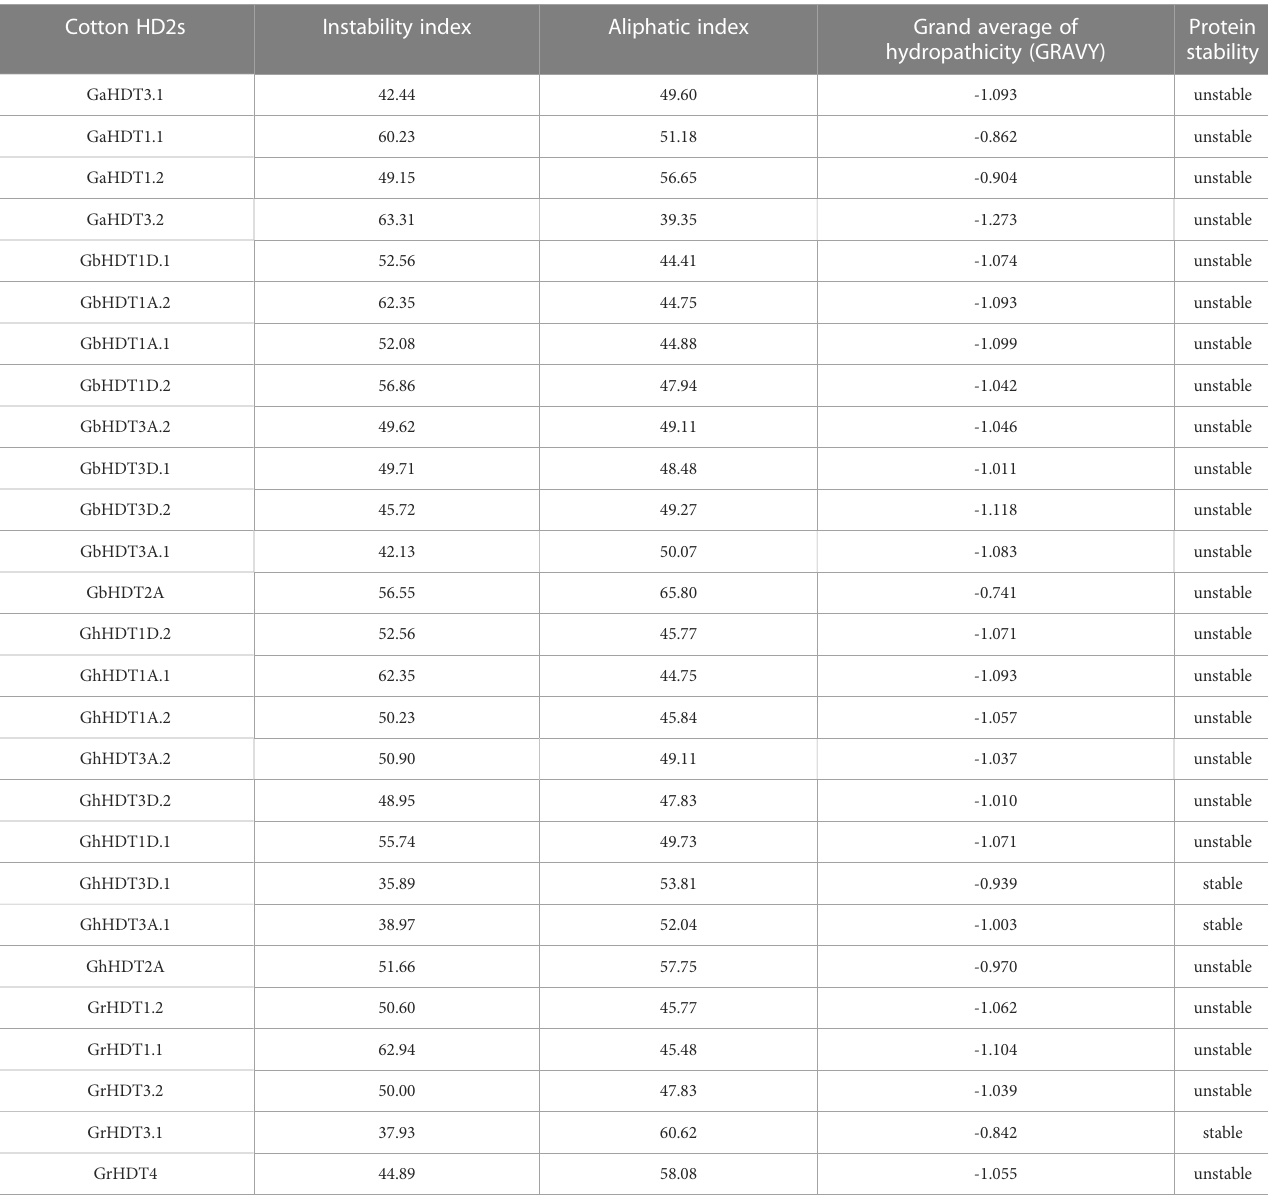
TABLE 2 Protein properties of different HD2s. Cotton